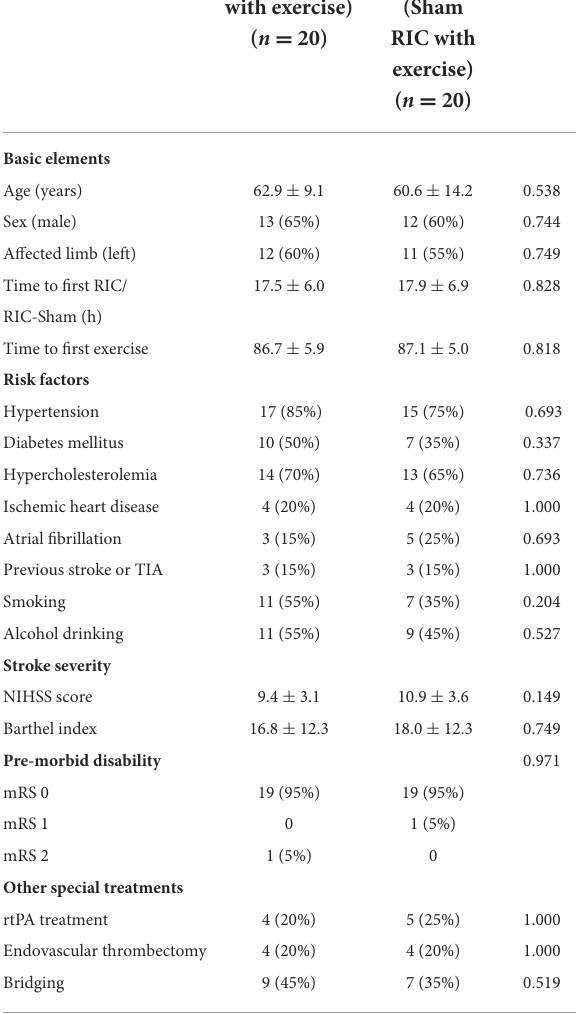
TABLE 1 Baseline characteristics of the